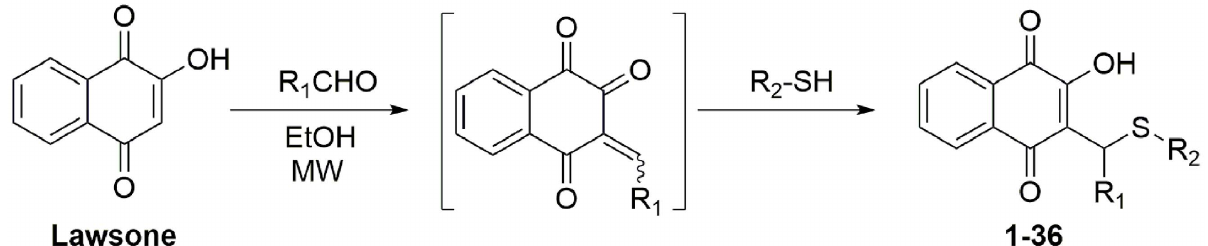
Figure 1. General scheme for preparing the 2-hydroxy-3-alkyl[1,4]naphthoquinones or 3-arylsulfanylmethyl[1,4]naphthoquinones under microwave irradiation.